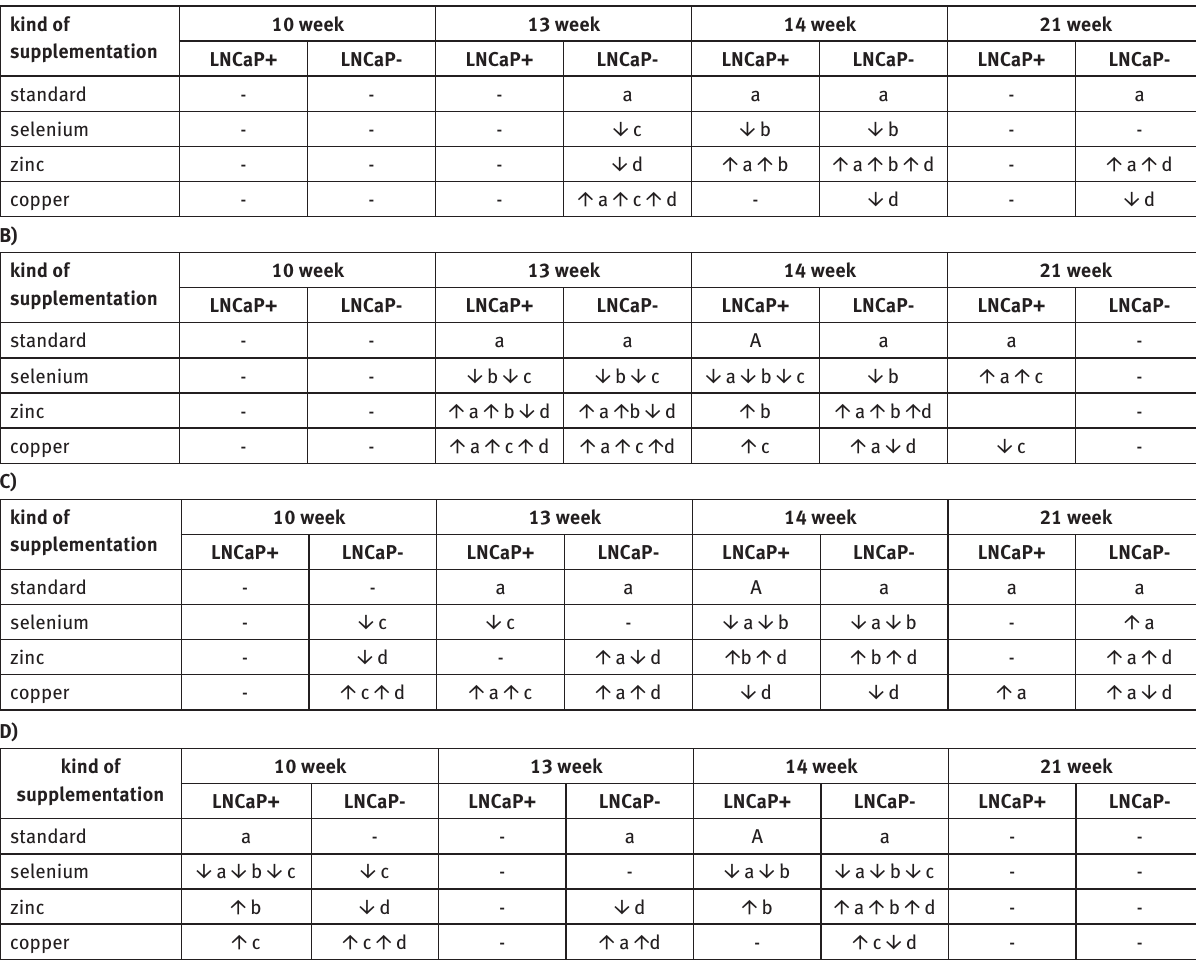
Table 2: Summary of the changes in relative levels of metabolites in urine of rats supplemented with Se, Zn and Cu and statistical analysis A) 7-methylguanine; B) 1-methylguanine; C) 3-methyladenine; D) 8-oxo-guanine